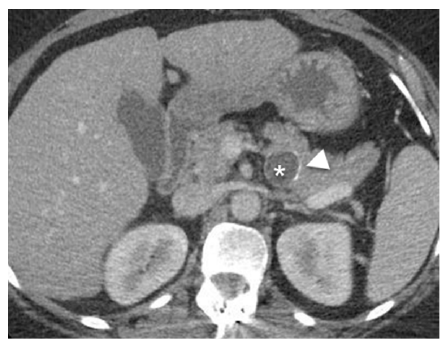
Figure 4. MCN. Axial CT image with IV contrast demonstrates a round cystic lesion in the pancreatic body (asterisk) with rim calcification (arrowhead).